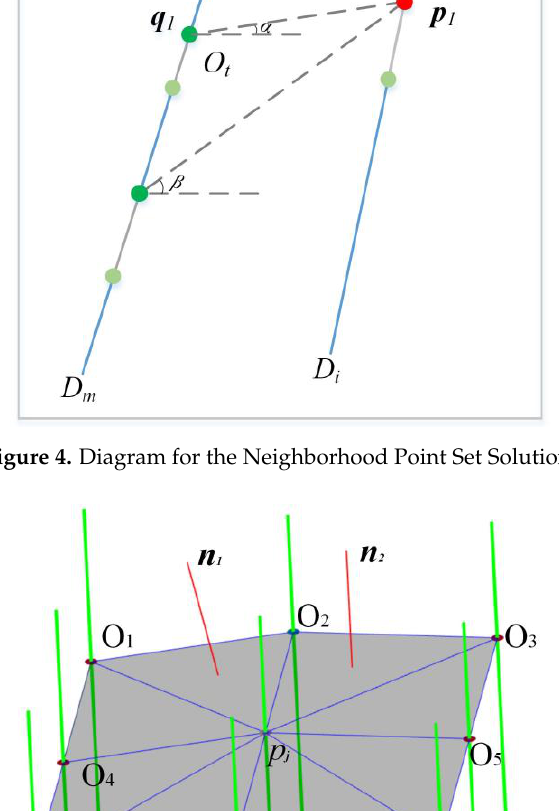
Figure 6. Borehole Data for Case I and Case II.